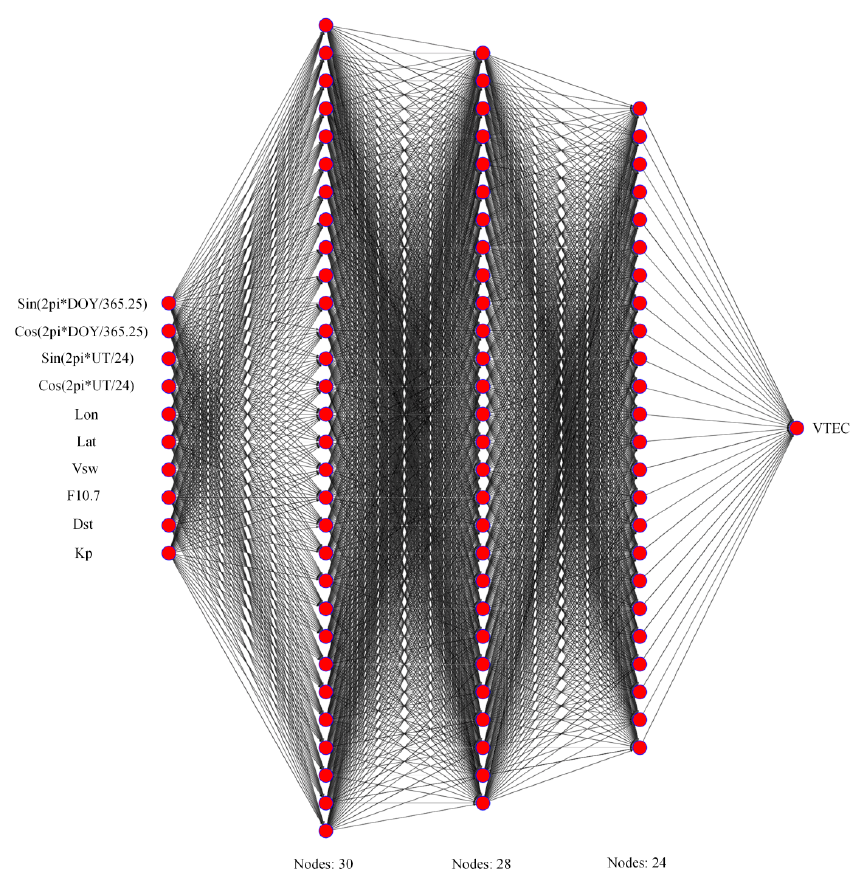
Atmosphere 2023 , 14 , x FOR PEER REVIEW Figure 2. Structure of the Japanese Ionospheric Model (JIM) based on the neural network.